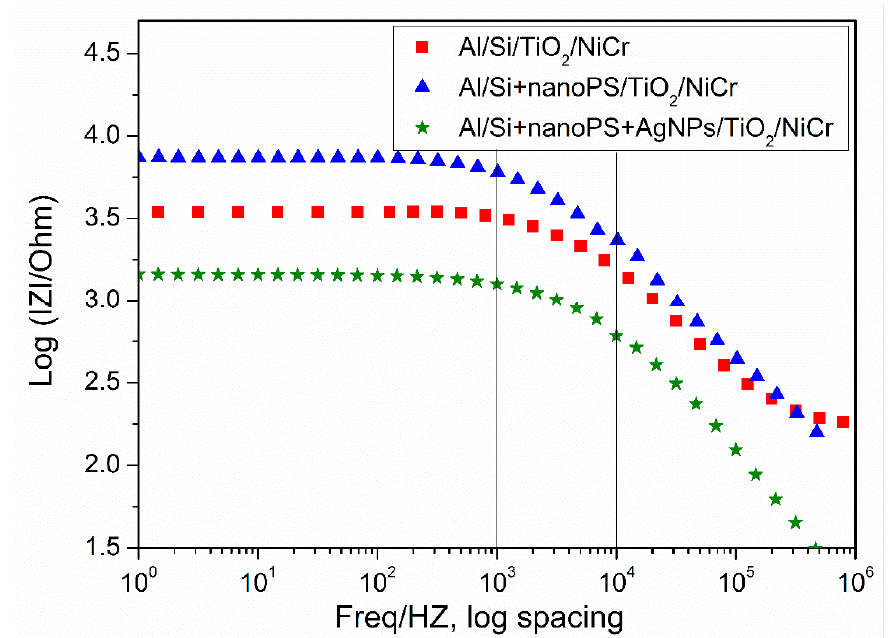
Figure 5. Bode diagram to study the e ff ect of frequency on the total impedance for the three MIS Schottky barrier devices